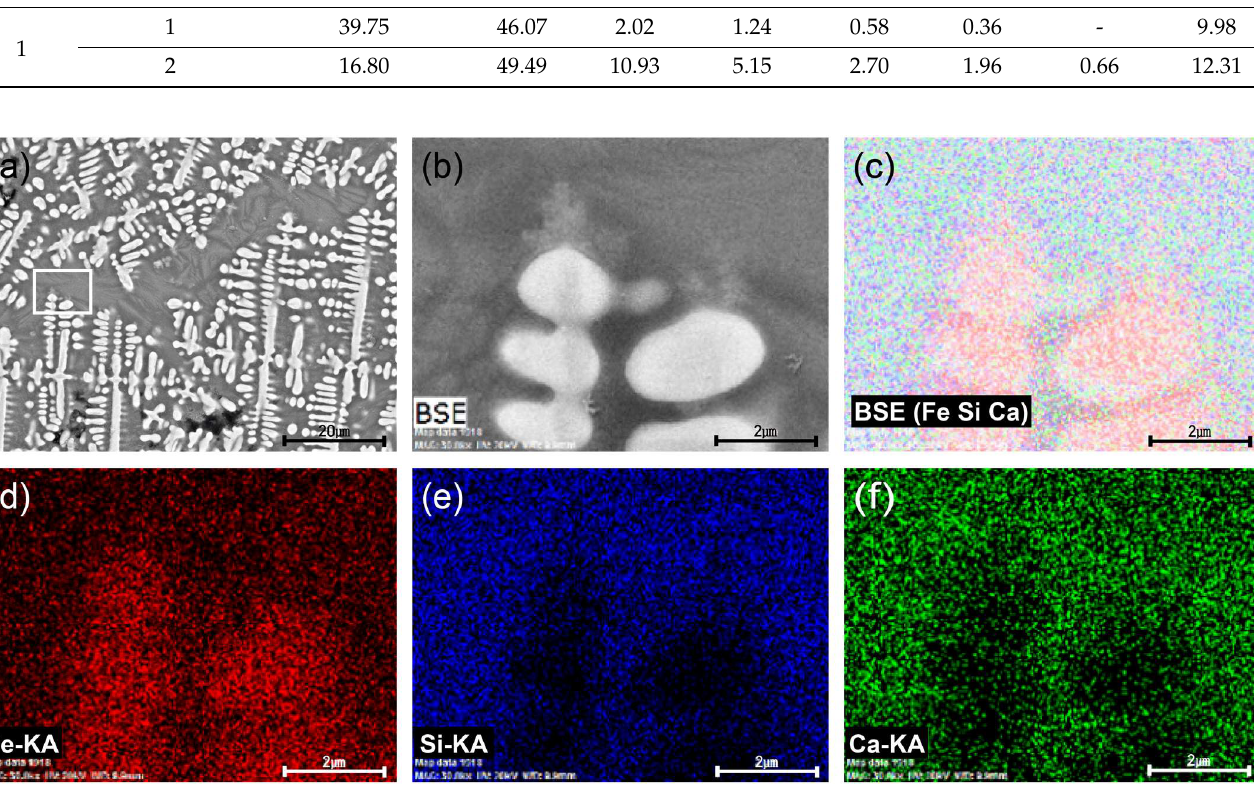
Figure 5. EDS mapping of spheroidal hammer scale (No. 1): ( a ) SEM image and position marking, ( b ) EDS mapping image, ( c ) distribution status of Fe, Ca, and Si elements, ( d ) Fe, ( e ) Si, ( f ) Ca.